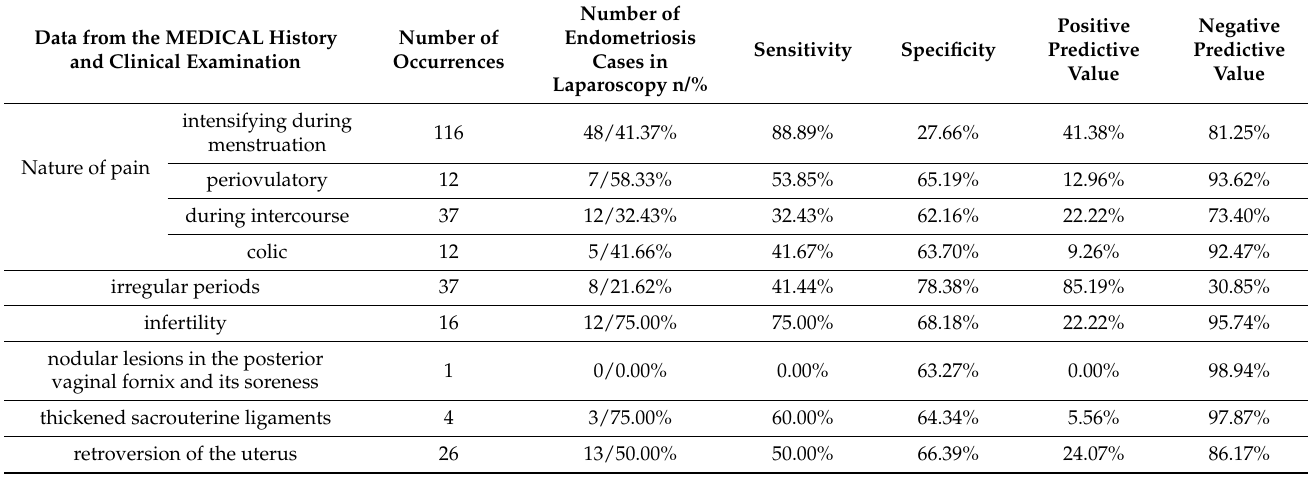
Table 2. Sensitivity, specificity, positive predictive value, and negative predictive value of individual symptoms in